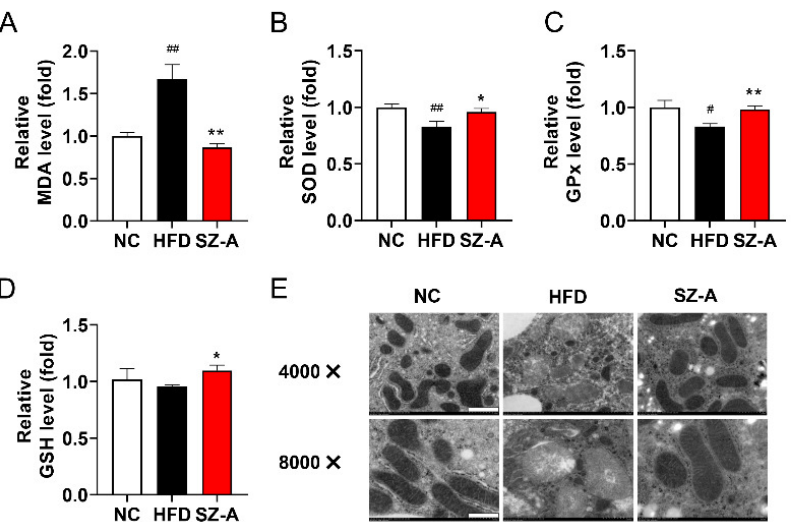
Figure 6. Effect of SZ-A on HFD-induced oxidative stress and mitochondrial damage. ( A – D ) Effects of SZ-A on liver MDA levels, SOD activity, GSH levels, and GPx activity ( n = 6/group). ( E ) TEM analysis of mitochondrial structure in 4000 × (scale bar 1 µ m) and 8000 × (scale bar 0.5 µ m) magnifications ( n = 3/group). Data are represented as mean ± SEM. # p < 0.05, ## p < 0.01 compared with the NC mice (i.g.), and * p < 0.05, ** p < 0.01 compared with the HFD mice (i.g.). NC, normal control; HFD, high-fat diet; SZ-A, Ramulus Mori (Sangzhi) alkaloids; MDA, malondialdehyde; SOD, superoxide dismutase; GSH, glutathione; GPx, glutathione peroxidase.